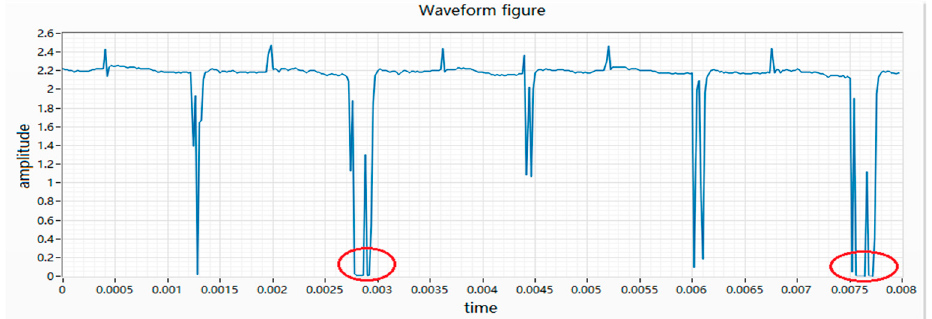
Figure 7. Waveform diagram of waveform fall.